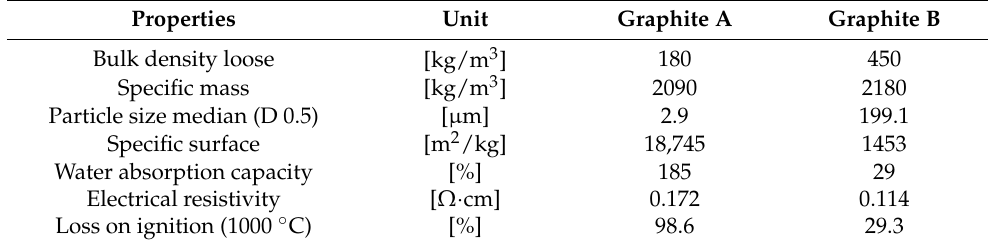
Table 1. Properties of graphite powders used.